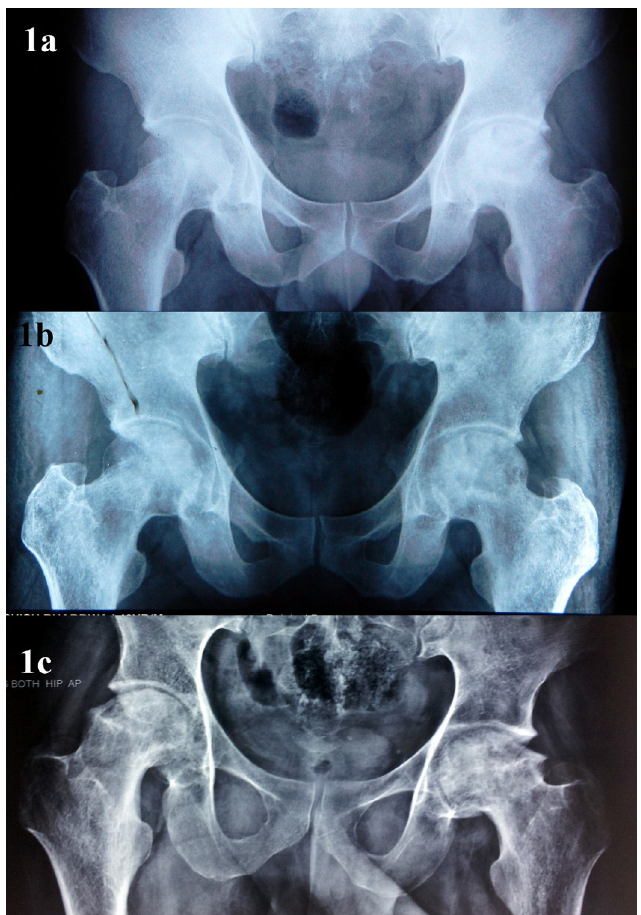
Figure 1. Serial radiographs of a 40 year old male with ONFH bilaterally: panel a: early stages showing density changes, more pronounced in left hip; panel b: after 3 months, fragmentation changes have appeared in both femoral heads. Femoral head collapse is eminent at this point; panel c: 1 year follow-up shows partial collapse in both femoral heads, relatively preserved joint space, relative fl attening at the lateral periphery of the femoral heads, and formation of impinging cam-type